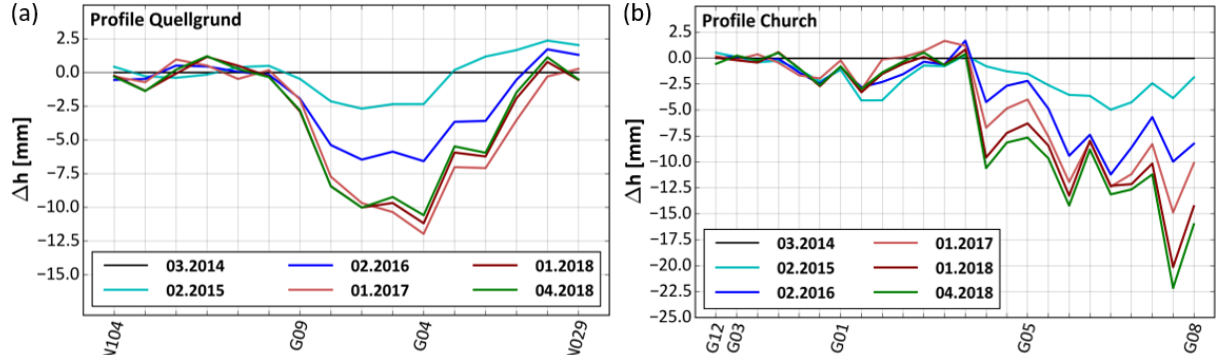
Figure 7. Levelling results along two selected profiles in the network (cf. Fig. 6) showing ongoing but irregular subsidence in yearly time intervals (curves are smoothed by a weighted moving average of width three and offset due to, e.g. effects of ground frost, to emphasize the evolving subrosion patterns). (a) Profile alongside and across the historical Quellgrund sinkhole shows subsidence of up to 12mm in the sinkhole and on its western–southwestern margin. (b) Profile around the leaning church tower shows subsidence of up to 22mm along the northern part of the church